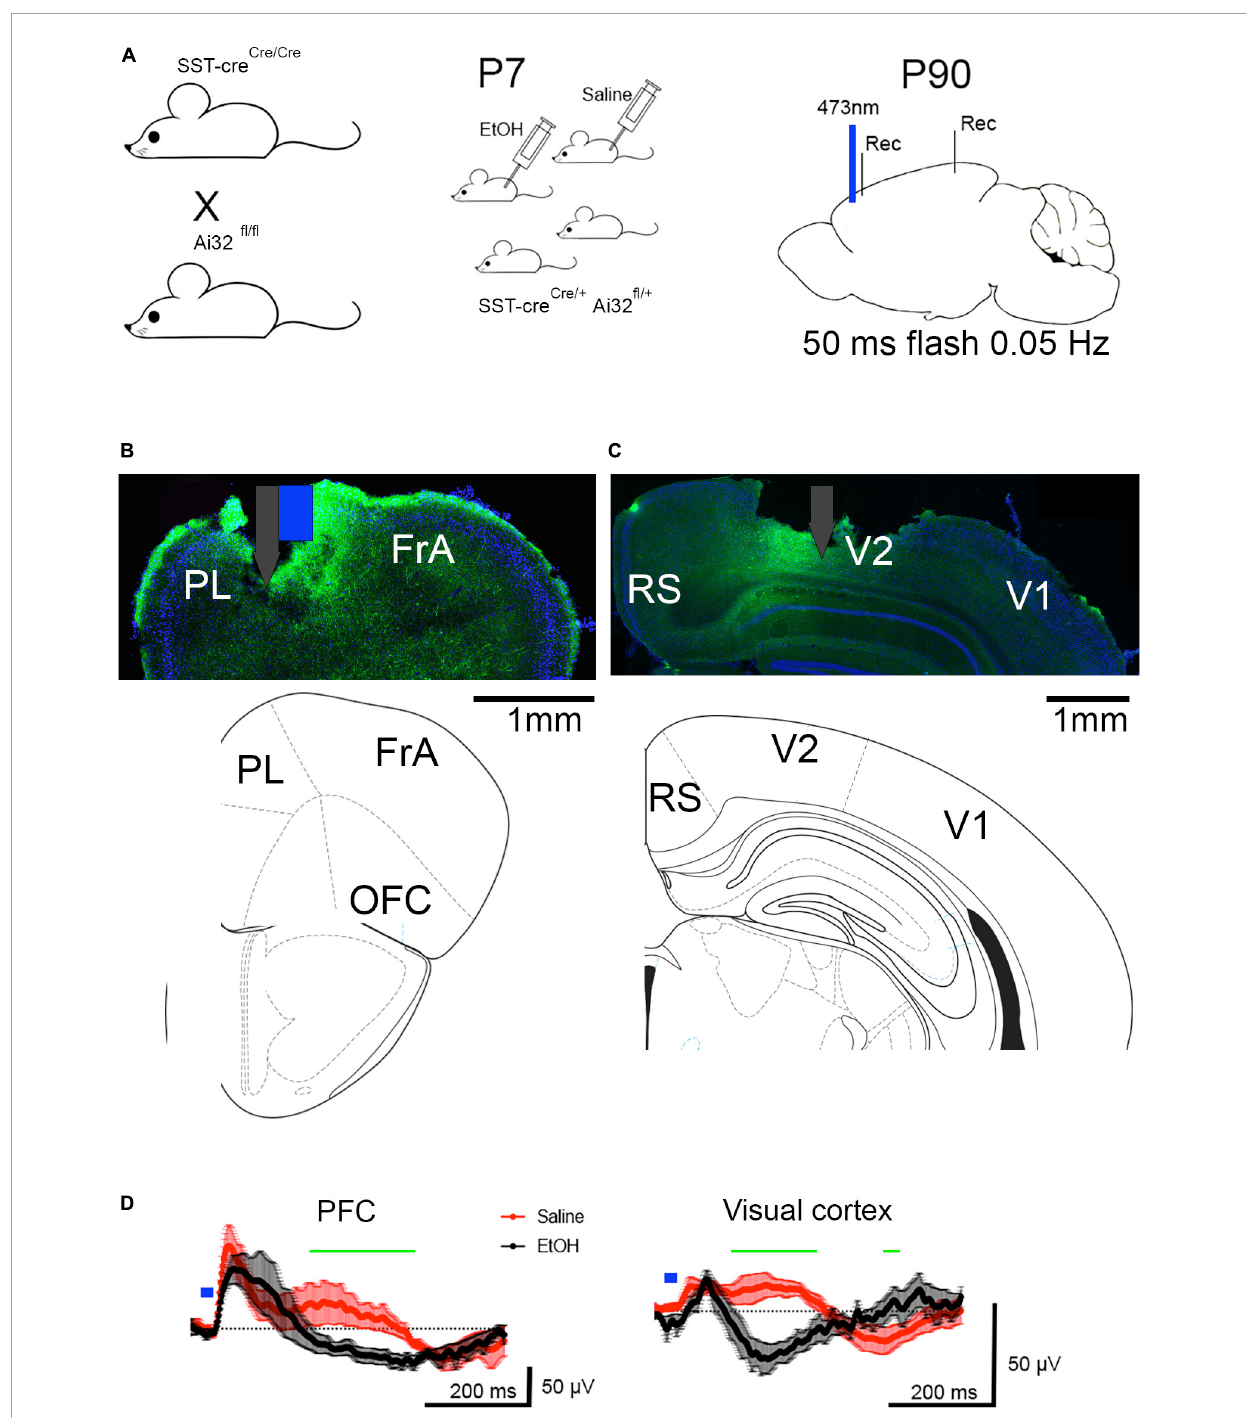
FIGURE2 (A) Adult SSTcreXAi32 mice exposed to EtOH ( n = 9) or saline ( n = 5) at P7, received optical stimulation of SST neurons in prefrontal cortex. (B) Histological section showing typical prefrontal cortex optotrode location (including surface damage during histology). Associated atlas image below. White and Blue markers denote electrode (gray) attached to optical fiber (blue). PrL, prelimbic cortex; FrA, frontal association cortex, OFC, orbitofrontal cortex. Blue shows DAPI staining and green shows SST-GFP expression. (C) Histological and atlas section showing visual cortex electrode location (including surface damage during histology). RS, retrosplenial cortex, V1, primary visual cortex, V2, secondary visual cortex. (D) Prefrontal cortex optical stimulation evoked a robust, positive wave lasting 200–400 ms, which corresponds to a 2–5 Hz oscillation (delta frequency band) in P7 saline-treated adult mice and which traveled the anterior-posterior extent of the neocortex, producing a similar, though smaller wave in the visual cortex. The same stimulation in P7 ethanol-treated adult mice evoked an early field potential without the later evoked slow-wave. No evoked slow-wave was observed in the visual cortex of P7 ethanol-treated mice. Shown are means (solid line, n > 5 mice) and SEM. Blue mark indicates 473 nm, 50 ms flash in prefrontal cortex. Repeated measures ANOVA detects a significant difference between evoked waveforms in saline and ethanol treated mice at time points marked by green horizontal line. In PFC, the difference between saline and ethanol responses was primarily > 200 ms post